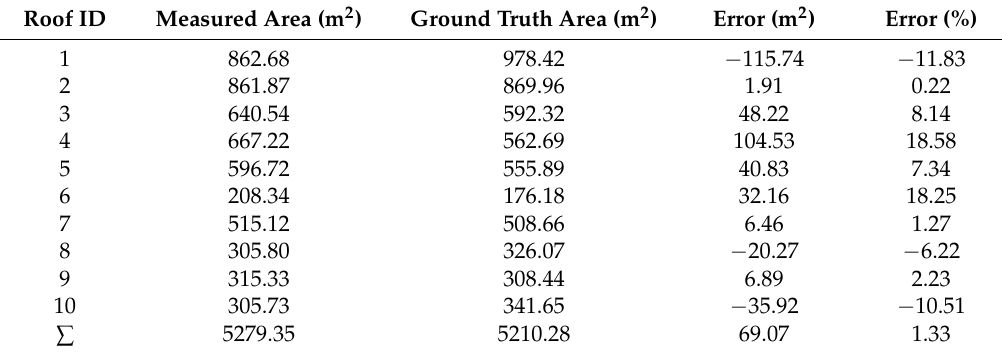
Table 3. Results for the First Expansion data sample.